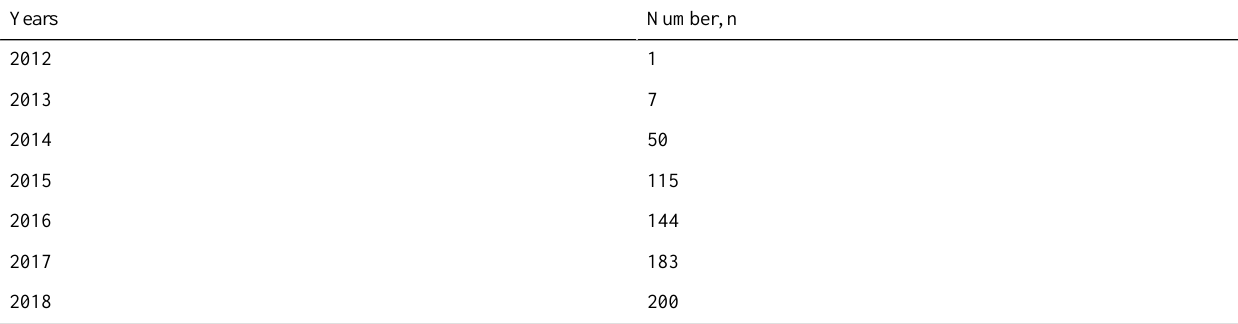
Table 5. The number of WeChat official accounts foundation